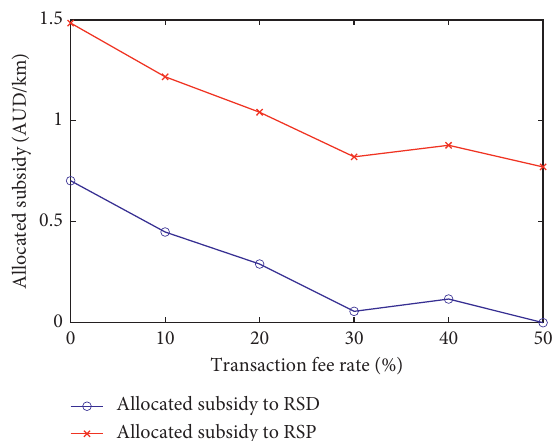
Figure 8: Subsidy allocated as a function of transaction fee